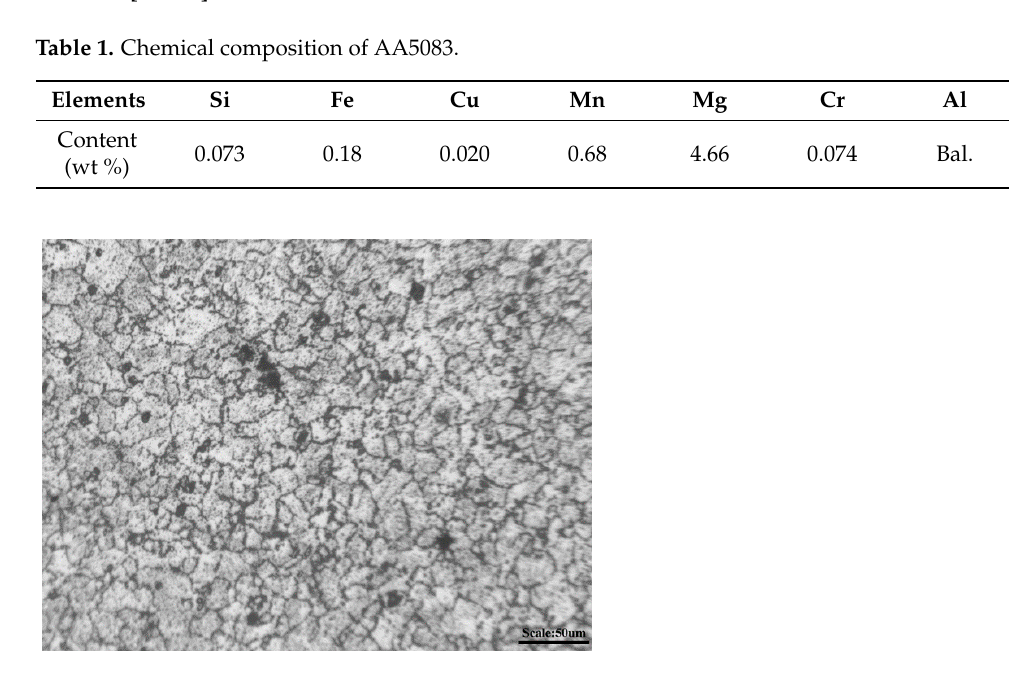
Figure 1. Initial microstructure of AA5083. Table 1. Chemical composition of AA5083.